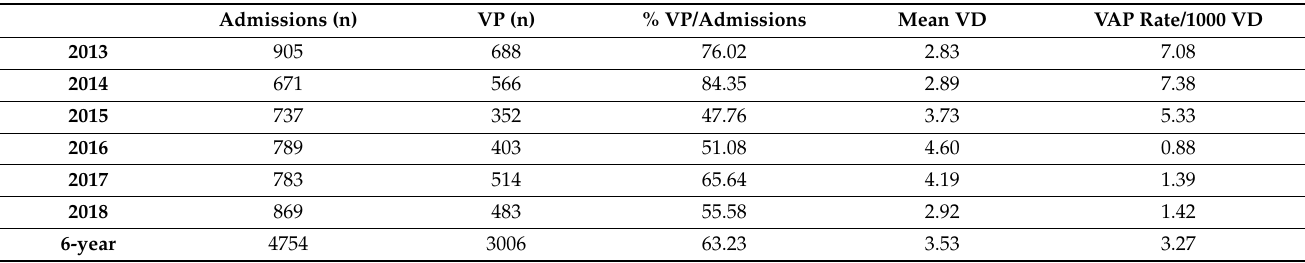
Table 2. Annual number of admissions, ventilated patients, mean ventilator-days, and VAP rates in ICU, January 2013 to December 2018.